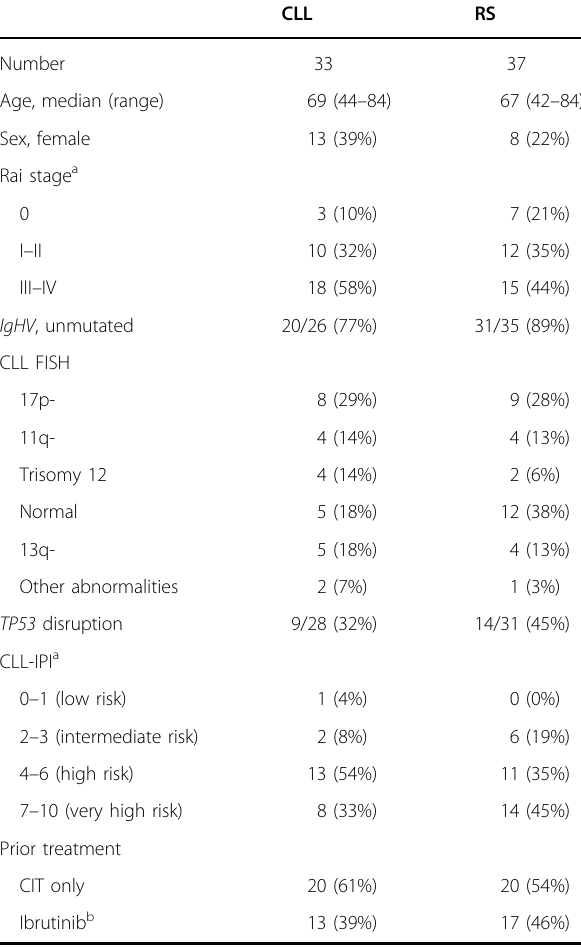
Table 1 Baseline characteristics of patients with CLL and